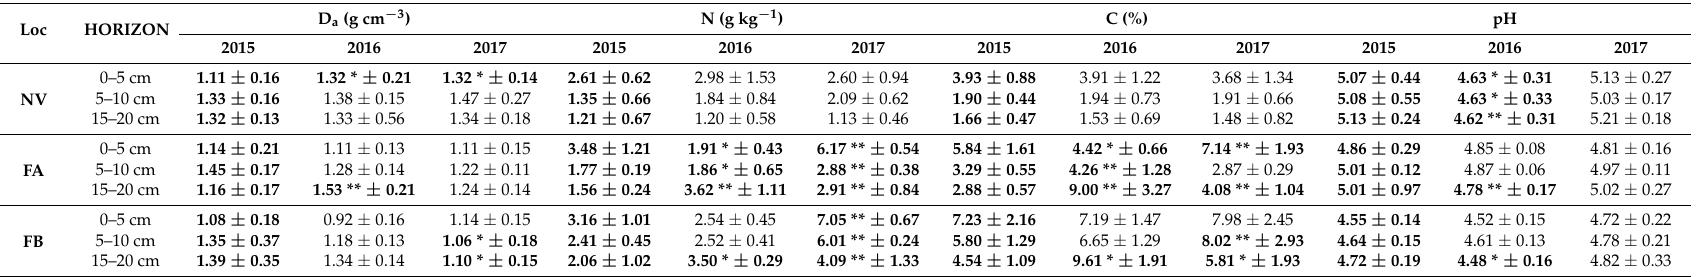
Values in bold indicate significant differences with respect to the situation before harvesting (* p < 0.05; ** p < 0.01) according to Newman-Keuls test. Loc: Locations according to Table